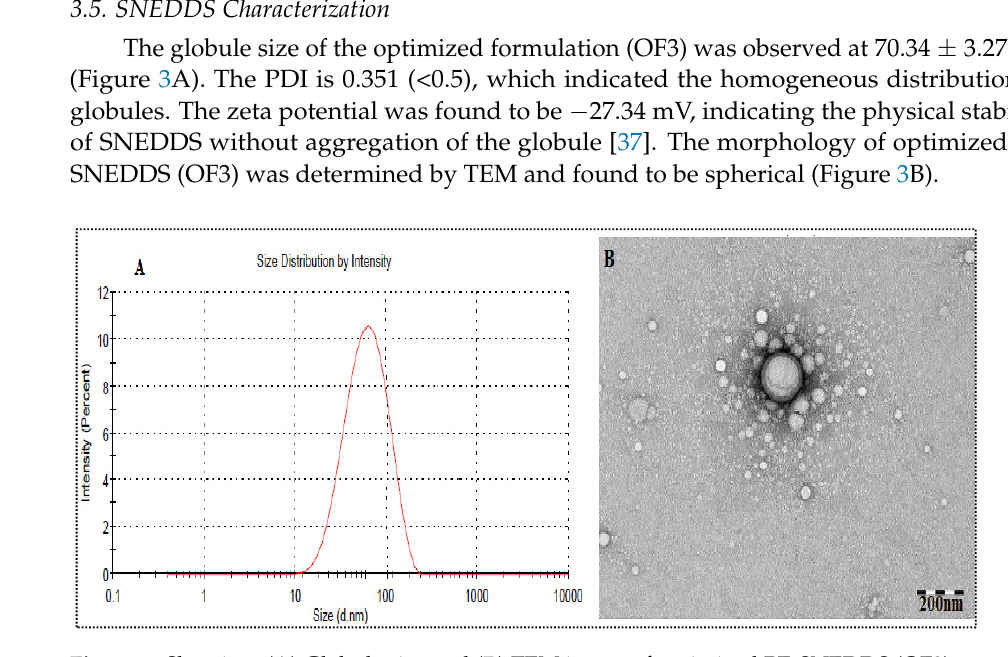
Figure 3. Showing: ( A ) Globule size and ( B ) TEM image of optimized PE-SNEDDS